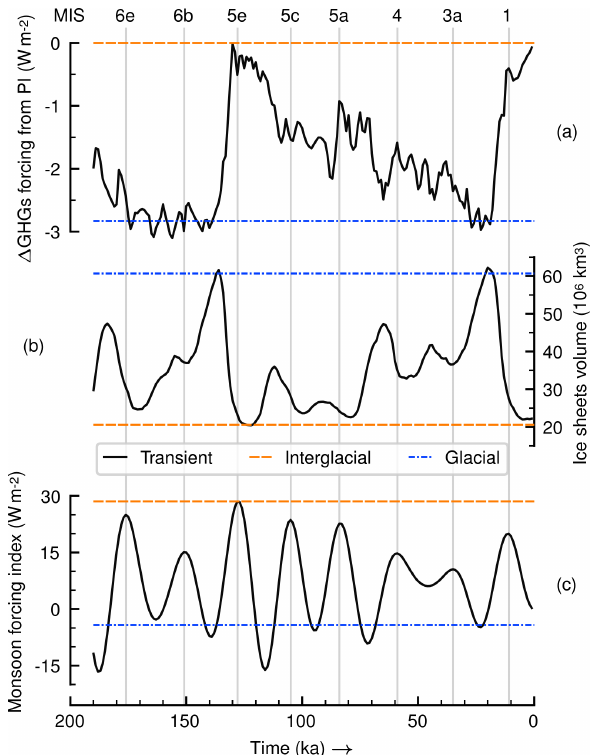
Figure 1. Prescribed forcing parameters in simulations: (a) GHG radiative forcing change ( (cid:49) ) from preindustrial (PI) era, (b) ice sheet global ice volume and (c) orbital forcing via the monsoon forcing index. Transient series come from Antarctic ice cores, mod- elled ice sheet data and orbital theory, respectively. Horizontal lines are cases when forcings are fixed to interglacial or glacial reference values. Vertical lines indicate maxima in the monsoon forcing in- dex and are labelled using MIS names on top (see Appendix A for details about